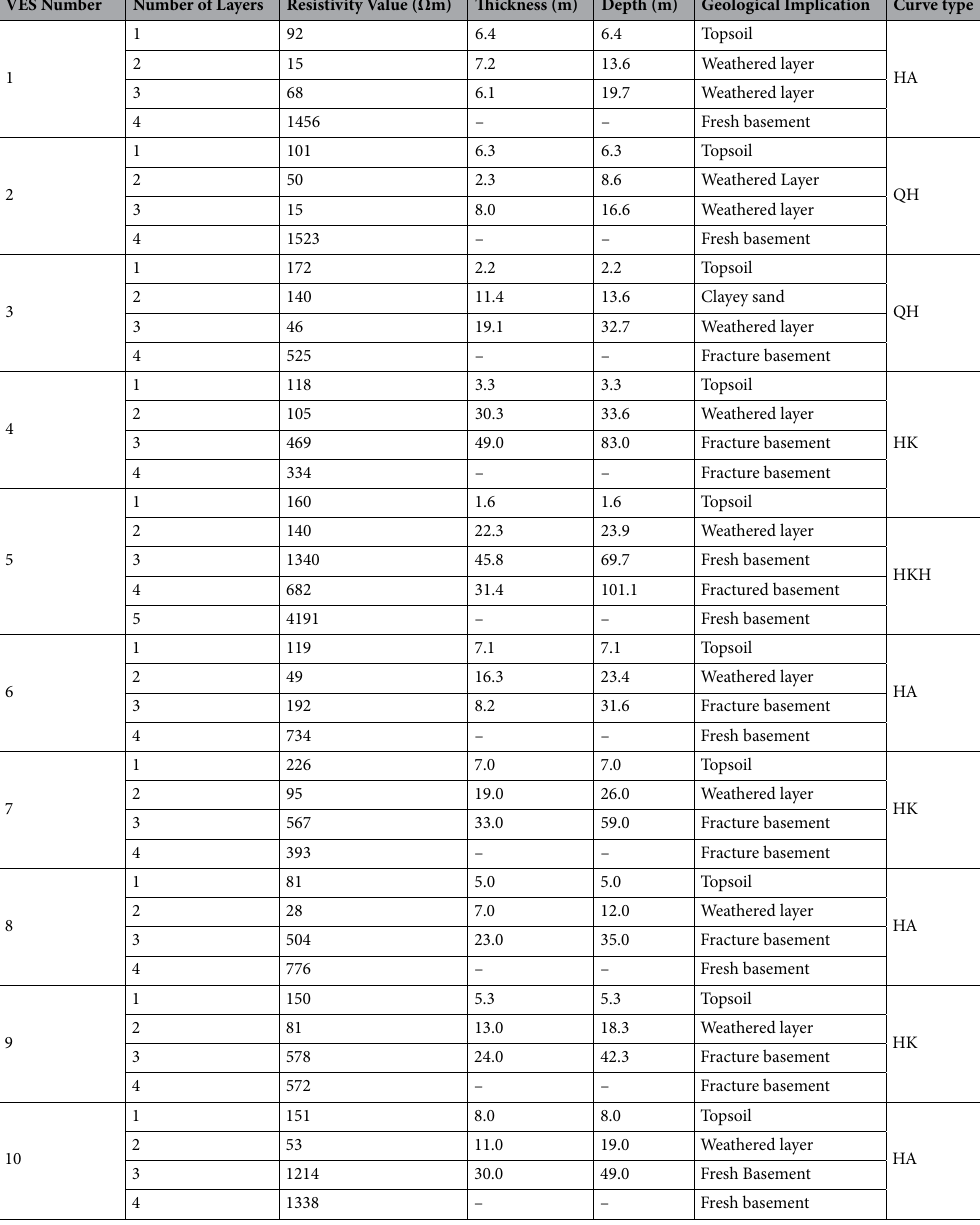
Table 6. Summary of the interpretation results and their lithologic unit